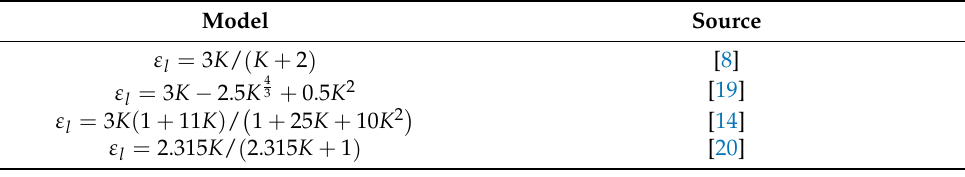
Table 3. Models from the literature relating relative conductivity to water content in a dispersion.